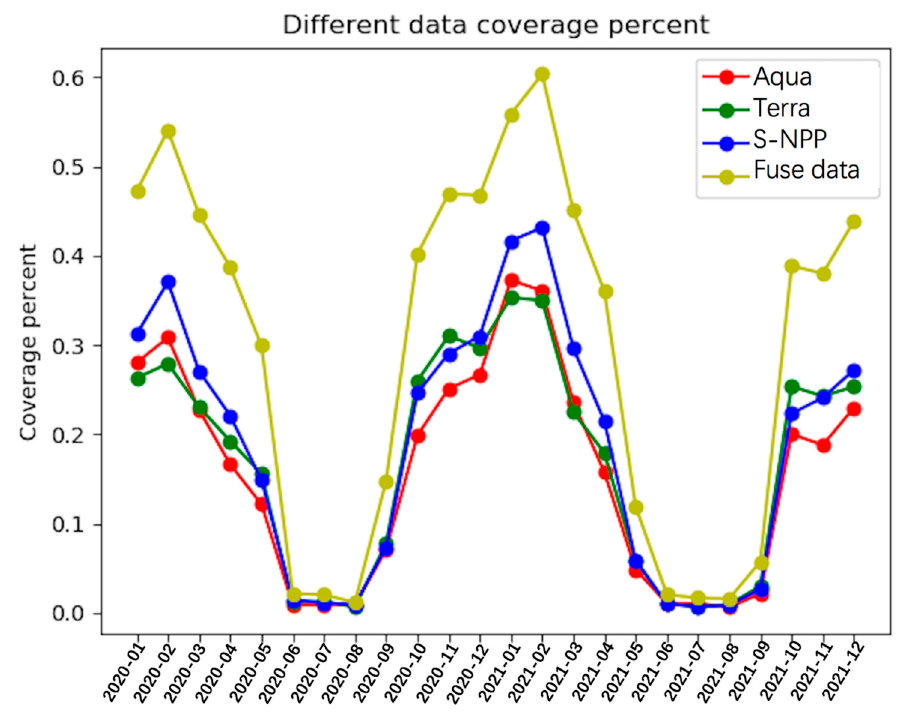
Figure 3. Aqua, Terra, S–NPP and the three satellites’ combined monthly percentages of coverage from 2020 to 2021.